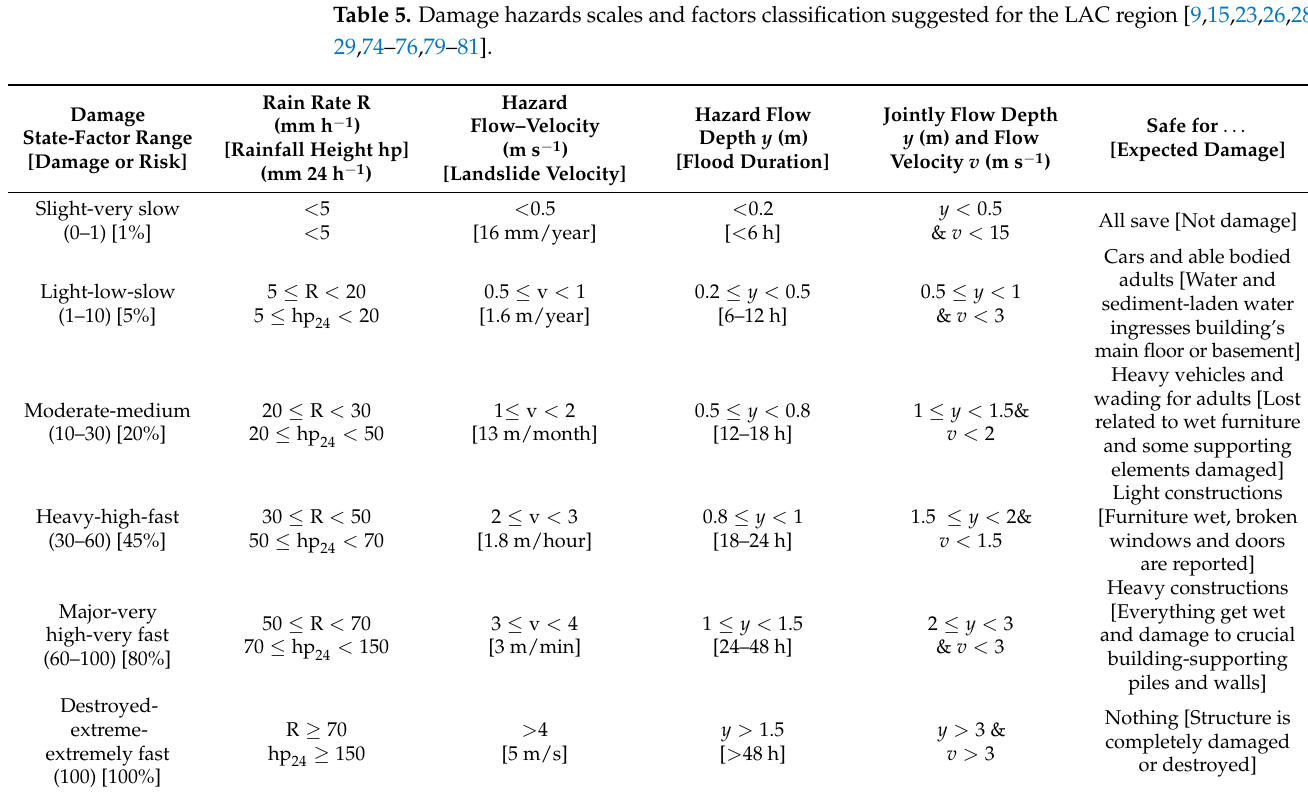
Table 5. Damage hazards scales and factors classification suggested for the LAC region